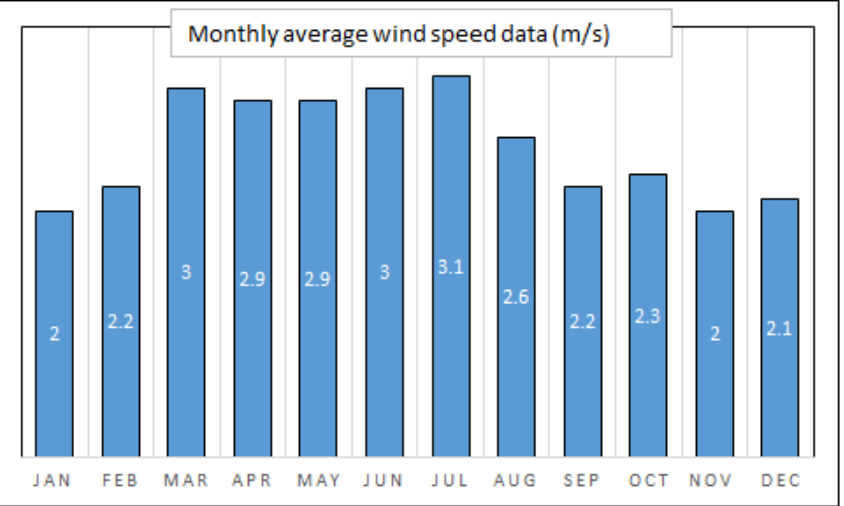
Figure 2. Monthly average wind speed data for